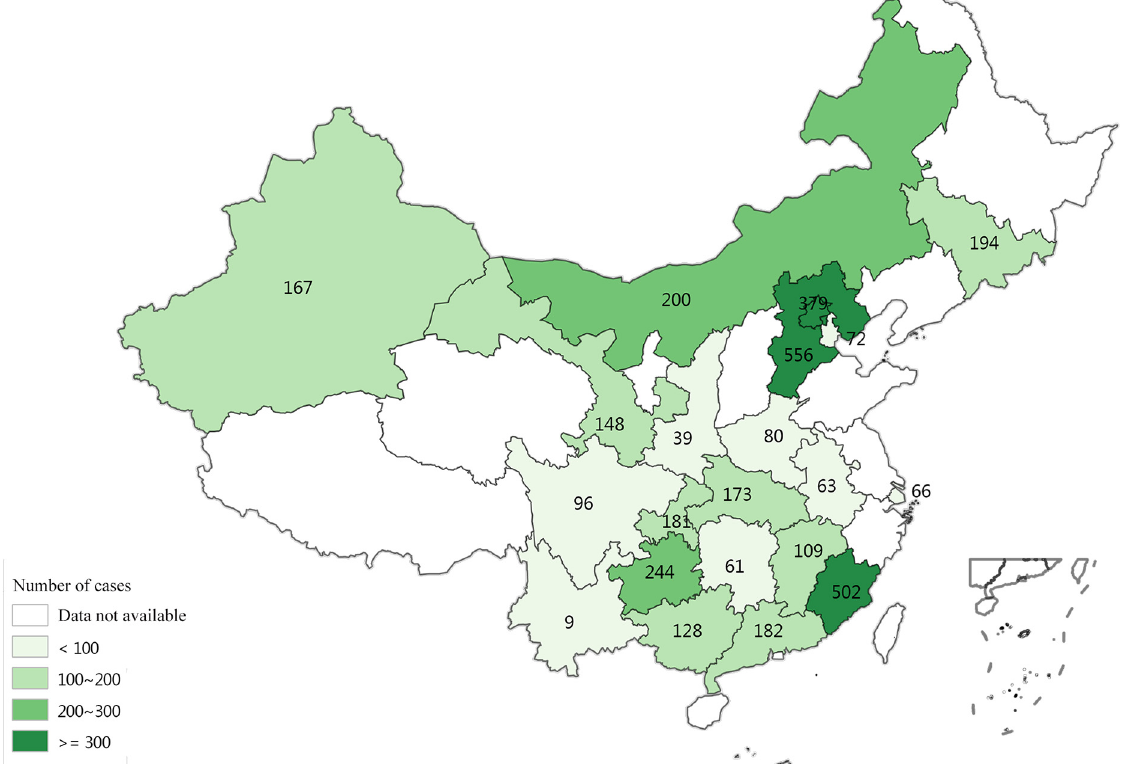
Fig 1. Geographical distribution of probable cases and laboratory-confirmed cases of mild HFMD by Chinese